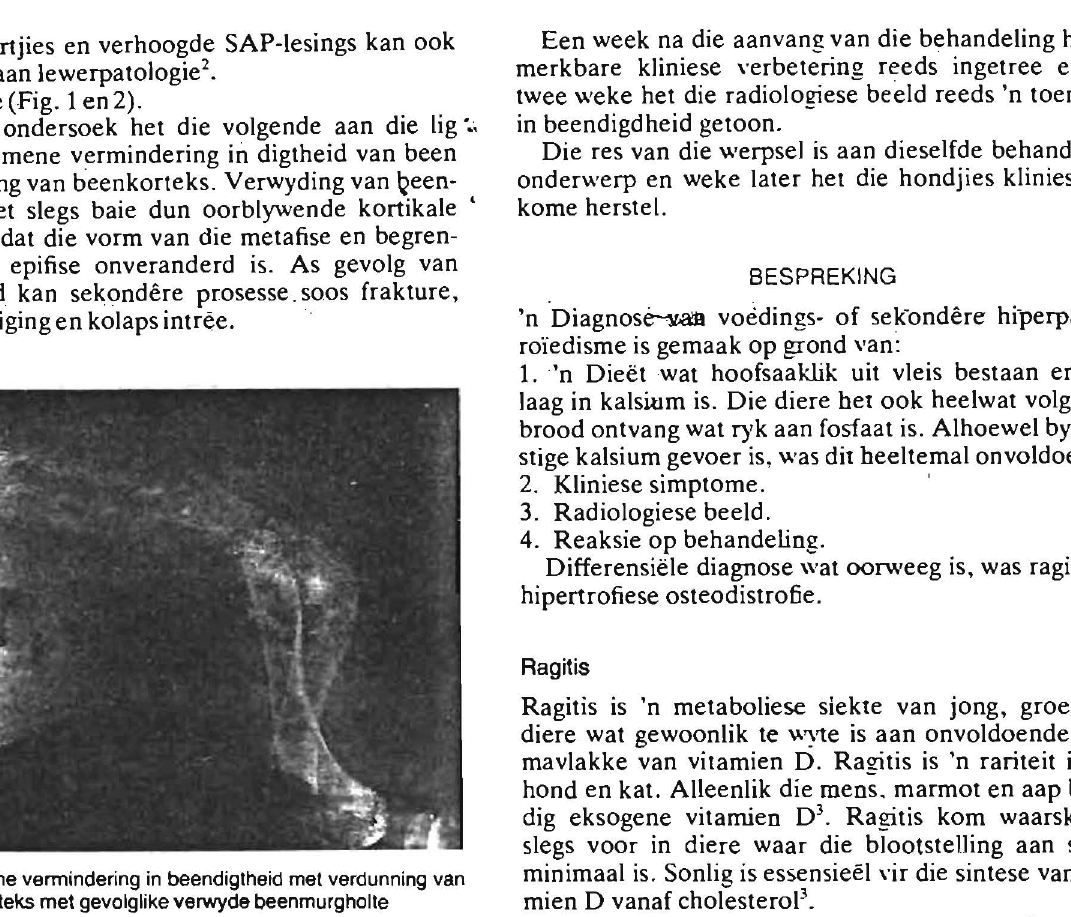
Fig 2 As gevolg van beenswakheid tree sekond~re prosesse so as frakture in BEHAN DE